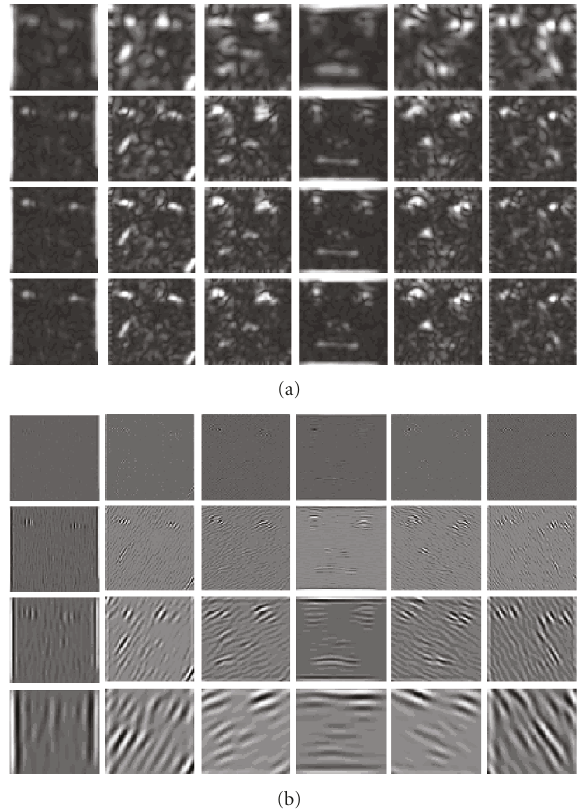
Figure 3: Gabor wavelet transformation of a sample image (top left face in Figure 12). (a) The magnitude of the transformation. (b) The real part of the